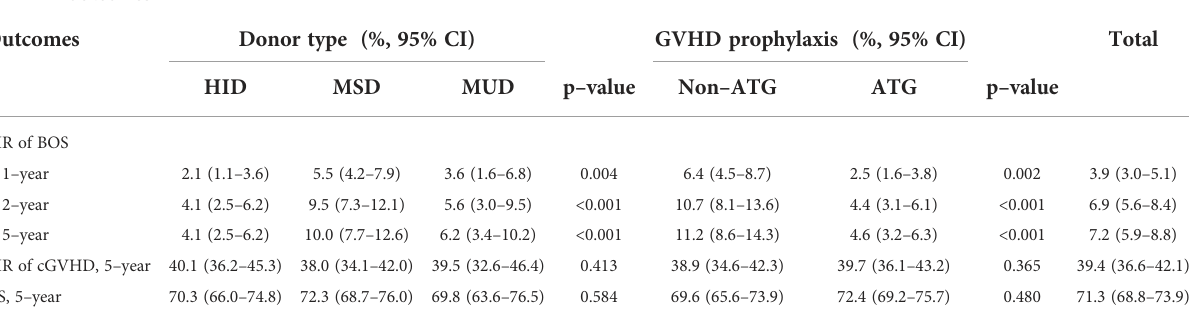
TABLE 2 Outcomes.